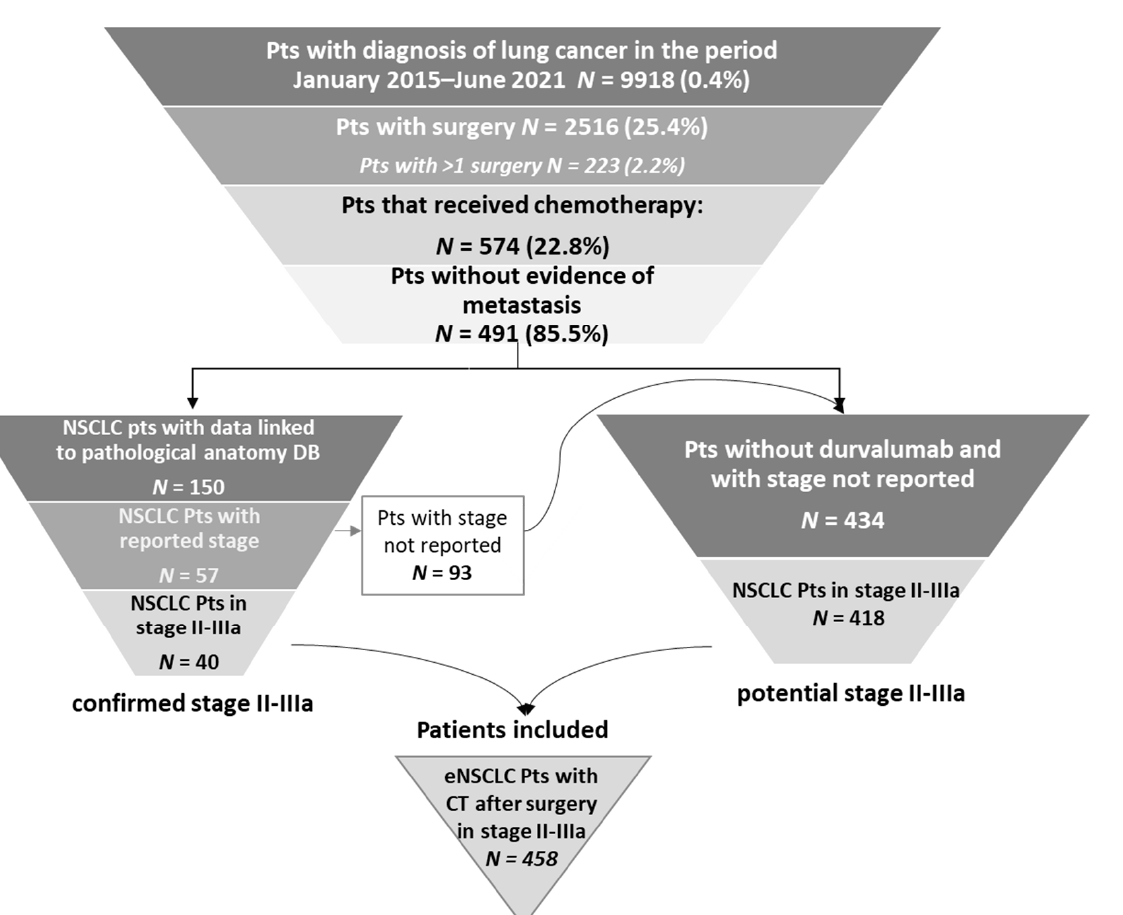
Table 1. Demographic and clinical characteristics of eNSCLC patients who had chemotherapy after surgery in stage II–III (study period January 2015–June 2021).